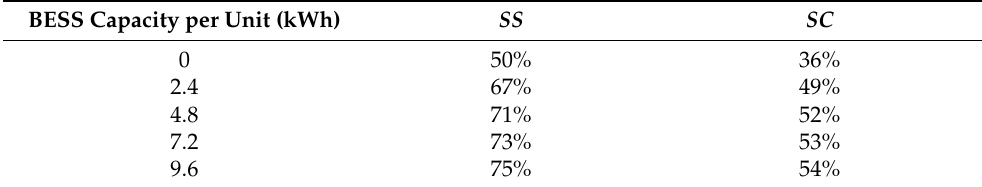
Table 11. Main results of the second